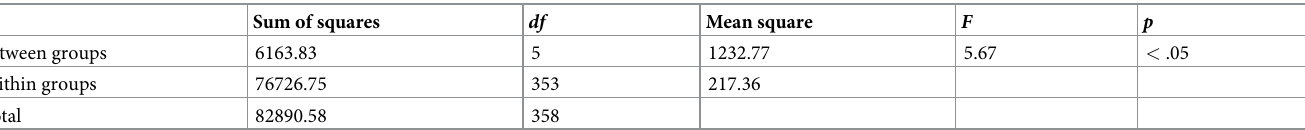
Table 2. The result of one-way analysis of variance.